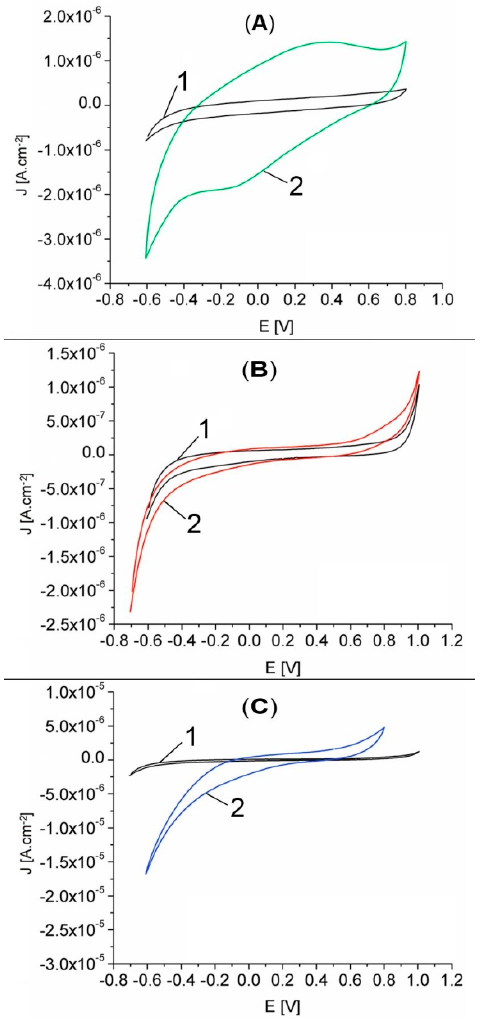
Figure 8. Cyclic voltammograms recorded in MES phosphate bu ff er solution, pH = 5.6, 50 mV / s, 25 ◦ C, for: ( A ) GCE (curve 1) and Pt-Porf-GCE (curve 2), cycle 3; ( B ) GCE in the absence (curve 1) and in the presence of 28.95 mM H 2 O 2 (curve 2); ( C ) GCE (curve 1) and Pt-Porf-GCE (curve 2) in the presence of 28.95 mM H 2 O 2